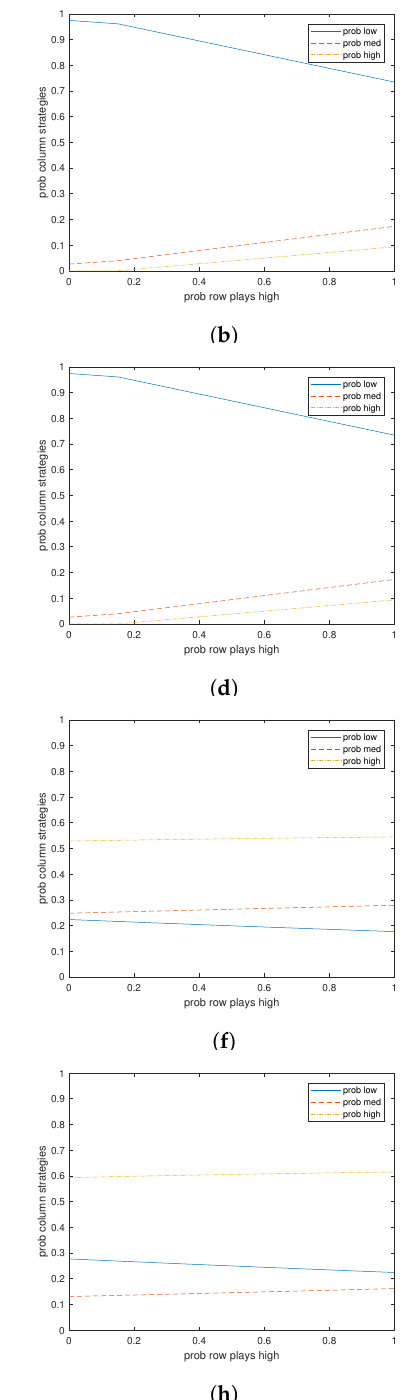
Figure 1. Best responses of the column player for a low payoff of the high action (left) and a higher payoff of the high action (right): ( a , b ) quadratic perturbations; ( c , d ) control perturbations; ( e , f ) logit perturbations; and ( g , h ) nested logit